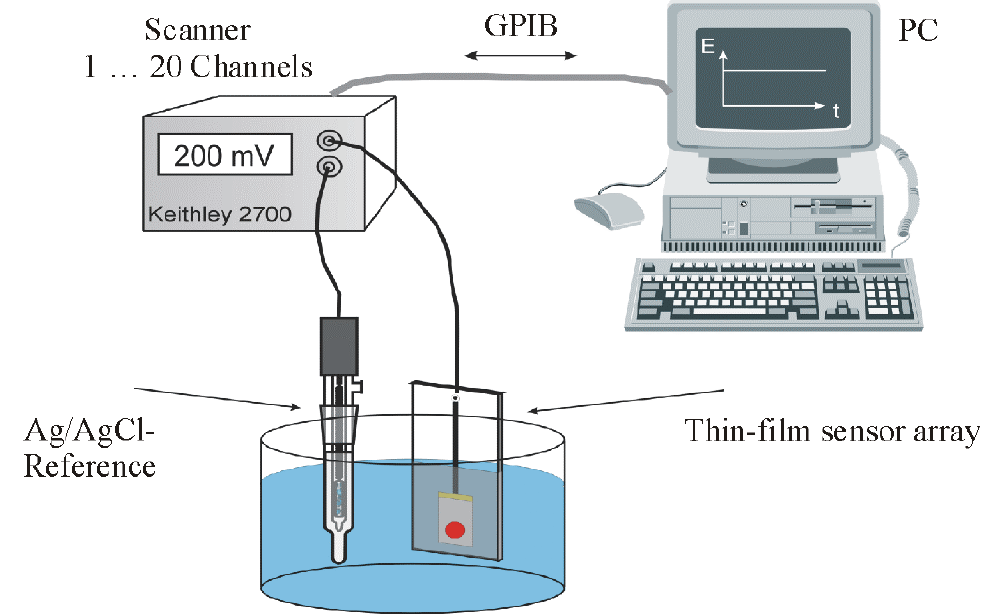
Figure 3 . Measurement set-up for the electrochemical characterization of the chalcogenide glass-based thin-film sensor